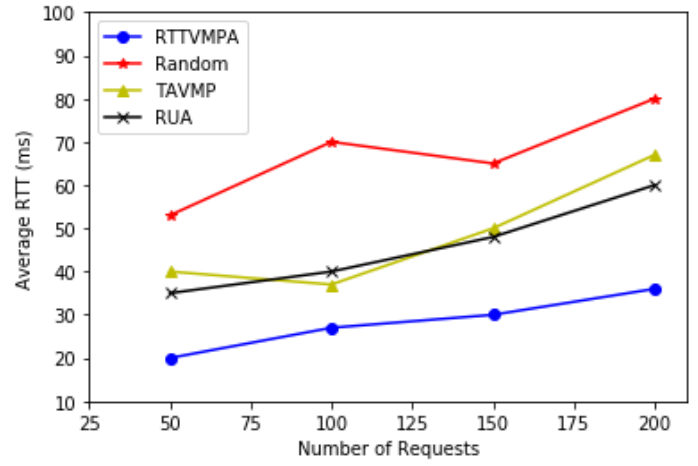
Figure 6. Number of pods affect average RTT.